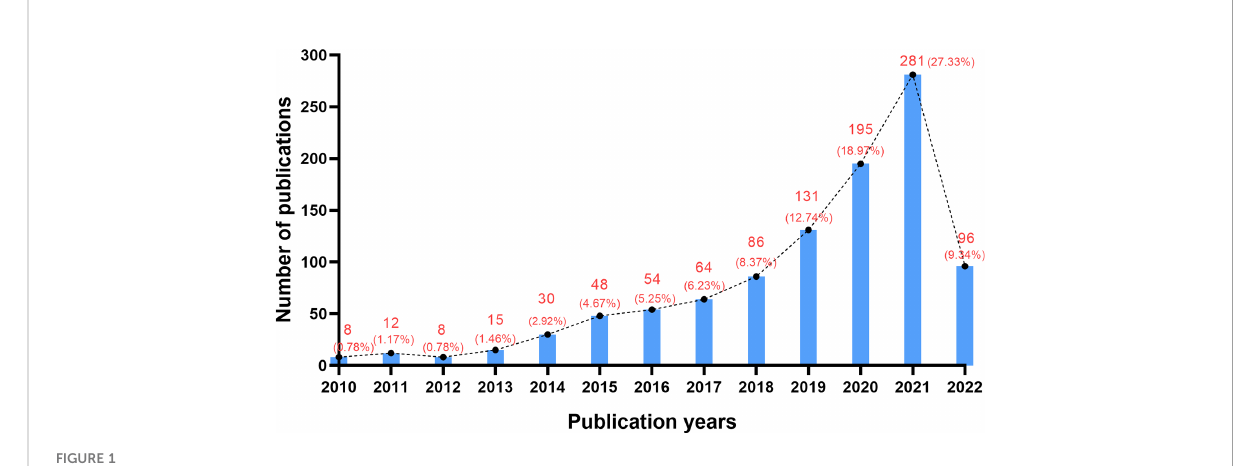
FIGURE 1 The trend of publication outputs about CAR-NK